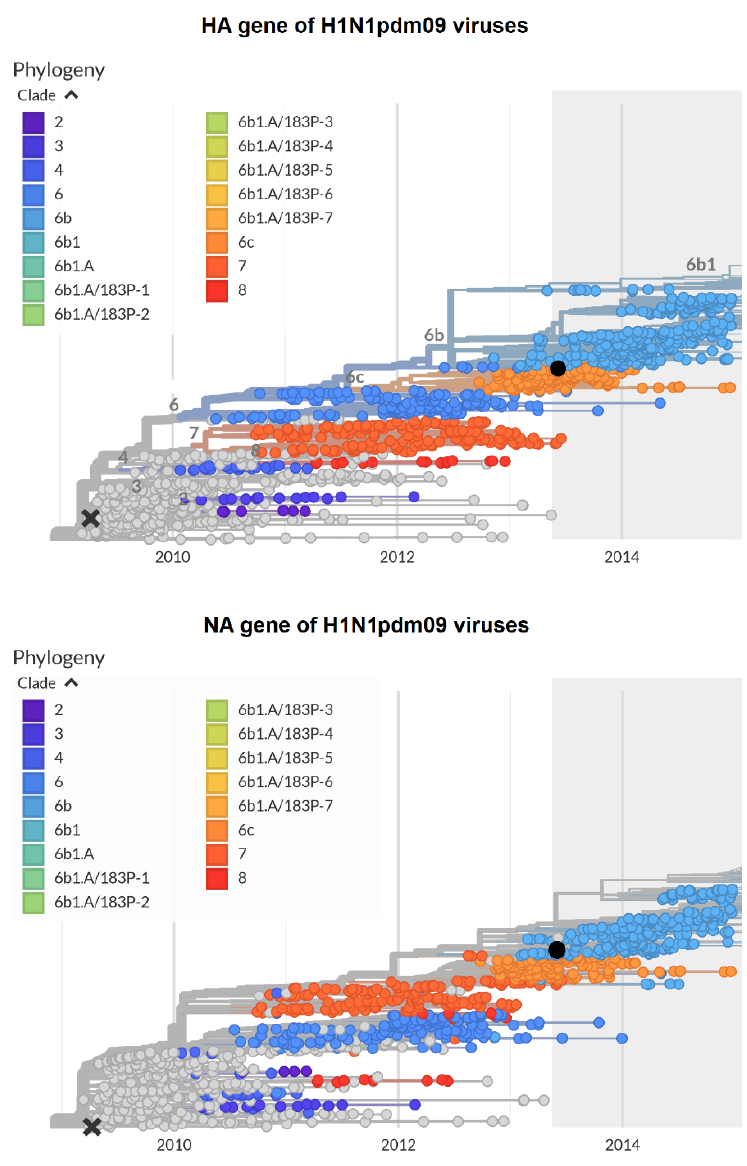
Figure 7. Phylogenetic trees of hemagglutinin ( upper panel ) and neuraminidase ( lower panel ) of the H1N1pdm09 influenza viruses. The website https://nextstrain.org/ [21] was used to construct the figure. Black cross: A/California/07/2009; black circle: A/South Africa/3626/2013.